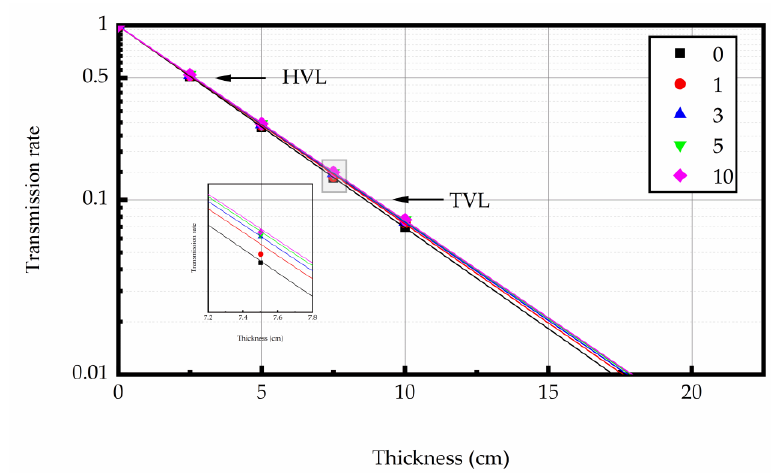
Figure 15. The relation between gamma-ray transmission rate and the concrete thickness at 200 °C.